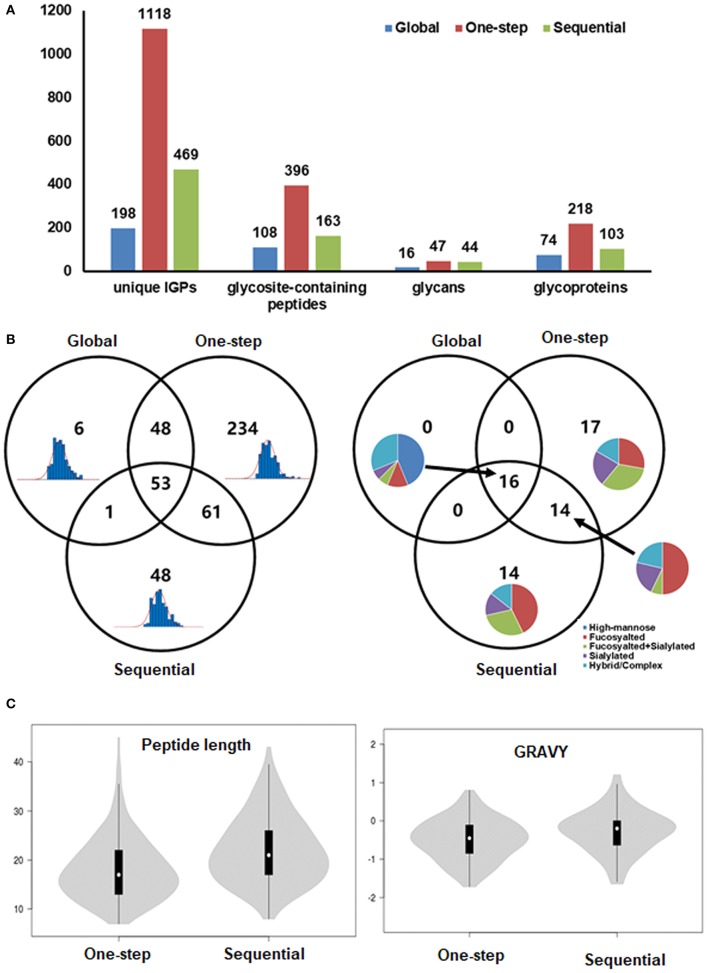
Enrichment of intact glycopeptides from FUT8 KO CHO cells by one-step and sequential methods. (A) Identification and distribution of intact glycopeptides, glycosites, and glycoproteins identified from FUT8 KO CHO cells by different methods. (B) Venn diagram of identified glycosites and their glycans by global, one-step, and sequential methods. (C) The length and grand average of hydropathy of identified glycopeptides enriched by one-step and sequential methods.